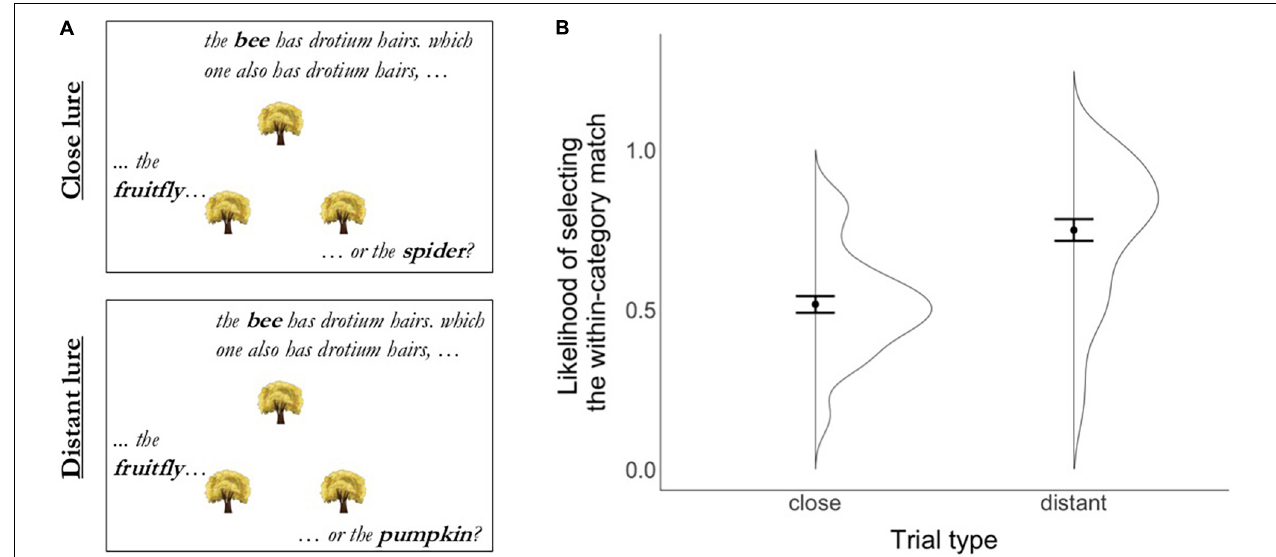
FIGURE 3 | Inference task. (A) Illustration of the close vs. distant lure manipulation; to indicate the placement of each organism, the object referred to was synchronously jittered while being labeled. (B) Likelihood of selecting the within-category match in the presence of a close vs. distant lure when asked to generalize an unobservable property from a target to either the match or the lure in the Inference task. Error bars represent standard errors of the